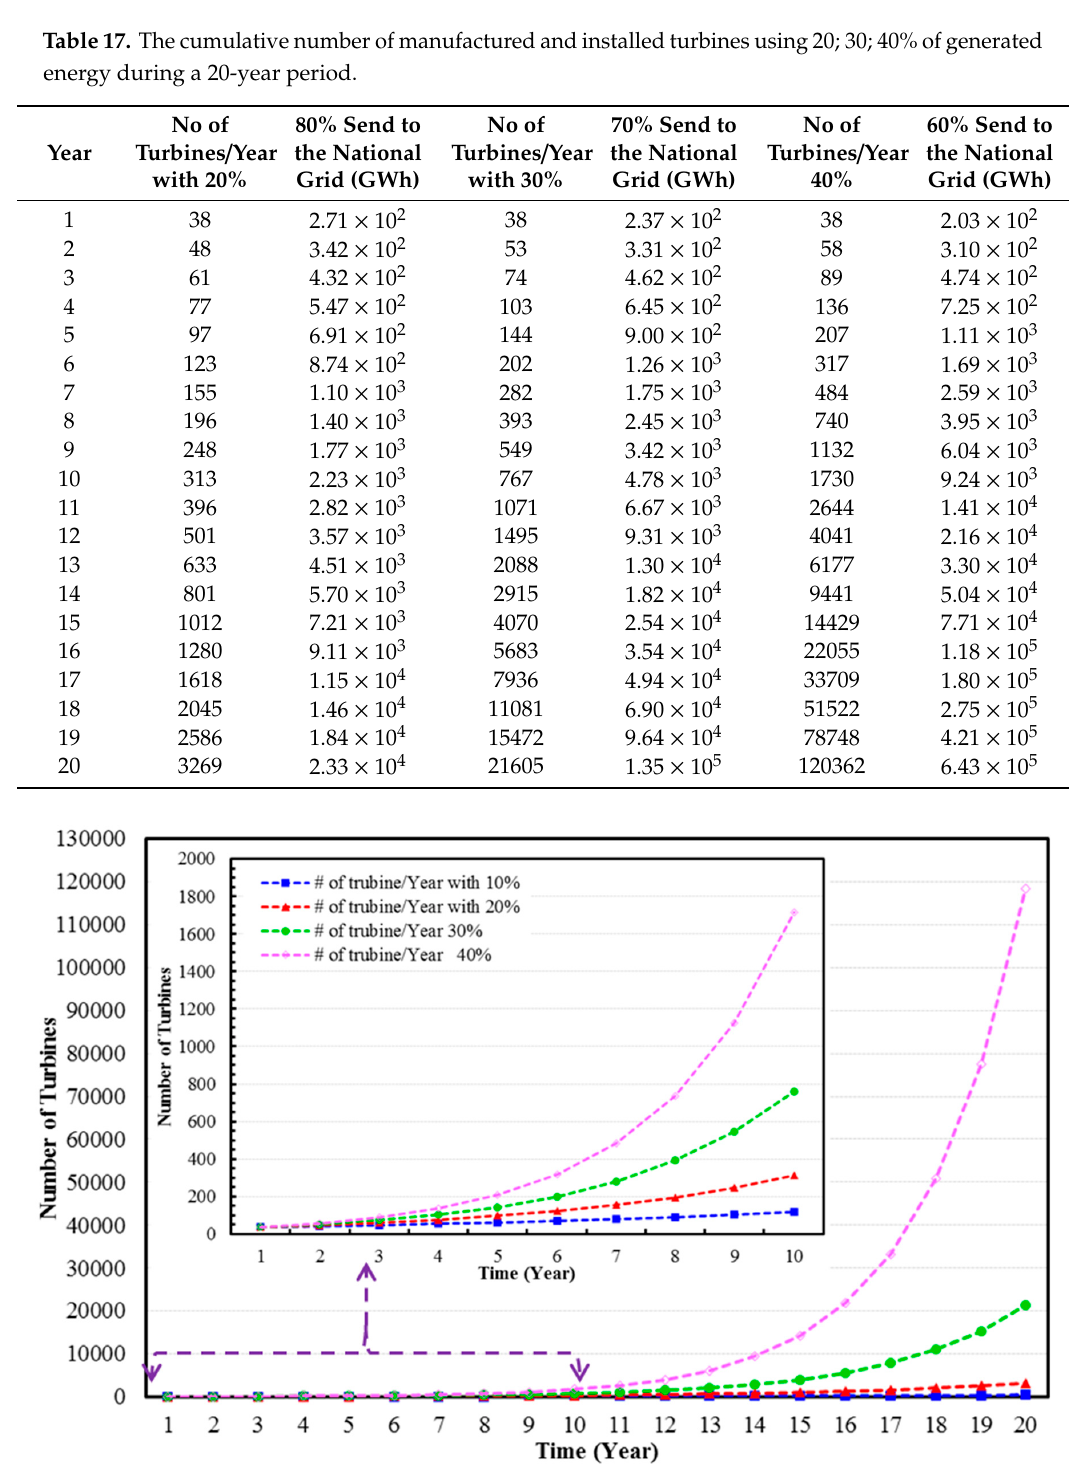
Figure 6. Cumulative number of (manufactured and installed) new turbines.